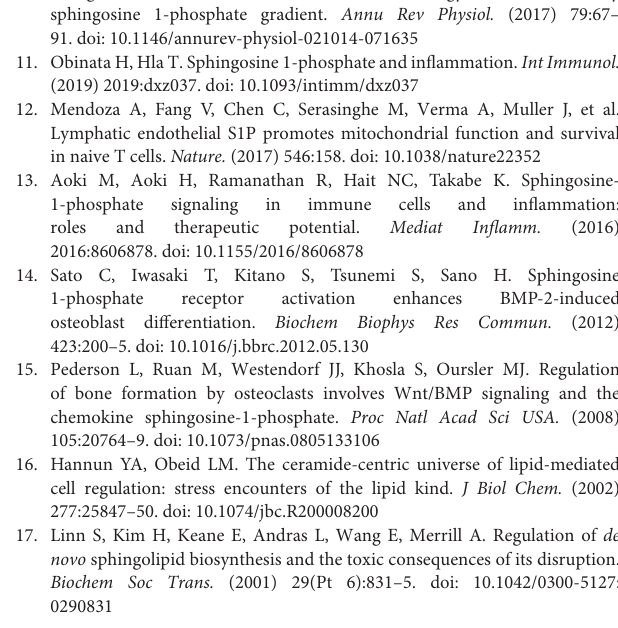
Figure S1 | The RANKL-RANK axis mediated osteoclastogenic signals. RANK is activated when combining with its ligand RANKL. Activated RANK then triggers the down-stream osteoclastogenic signaling cascades. Activated TRAF6 induces the MAPK, IKK, and NF- κ B signaling, which eventually result in activation of NFATc1 and osteoclastogenesis. RANKL: receptor activator of nuclear factor factor-kappa B ligand. RANK, receptor activator of nuclear factor-kappa B; TRAF6, tumor-necrosis factor (TNF) receptor-associated factor 6; IKK, inhibitor of nuclear factor kappa-B kinase; MAPK, mitogen-activated protein kinase; NF- κ B, nuclear factor kappa B; AP-1, activator protein1; ERK, extracellular signal regulated kinase; JNK, c-Jun N-terminal kinase; NFATc1, nuclear factor of activated T-cells, cytoplasmic